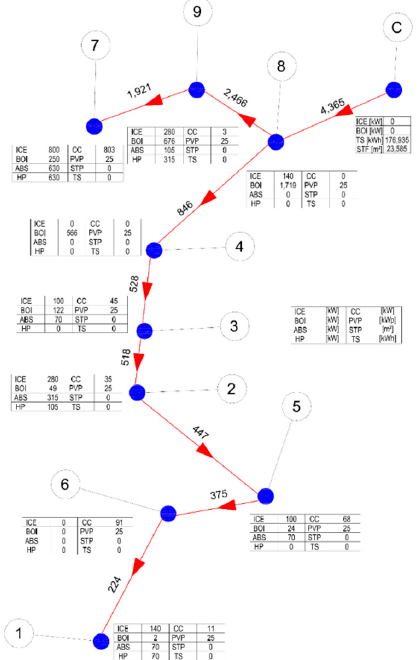
Table 14. Total optimal annual energy magnitudes (MWh)—distributed generation solutions integrated with the central solar system.